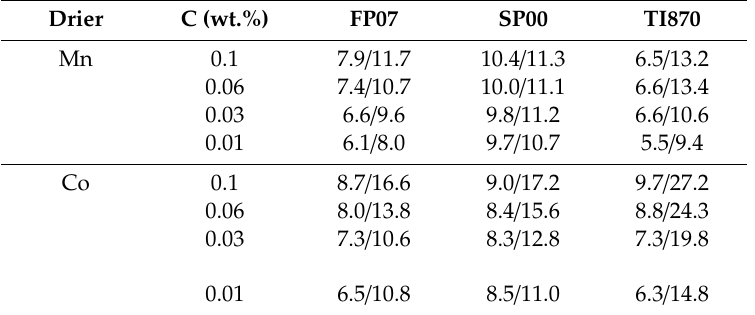
Table 5. Relative hardness (in %) of test coatings for formulations of high-solid alkyd binders. 1.